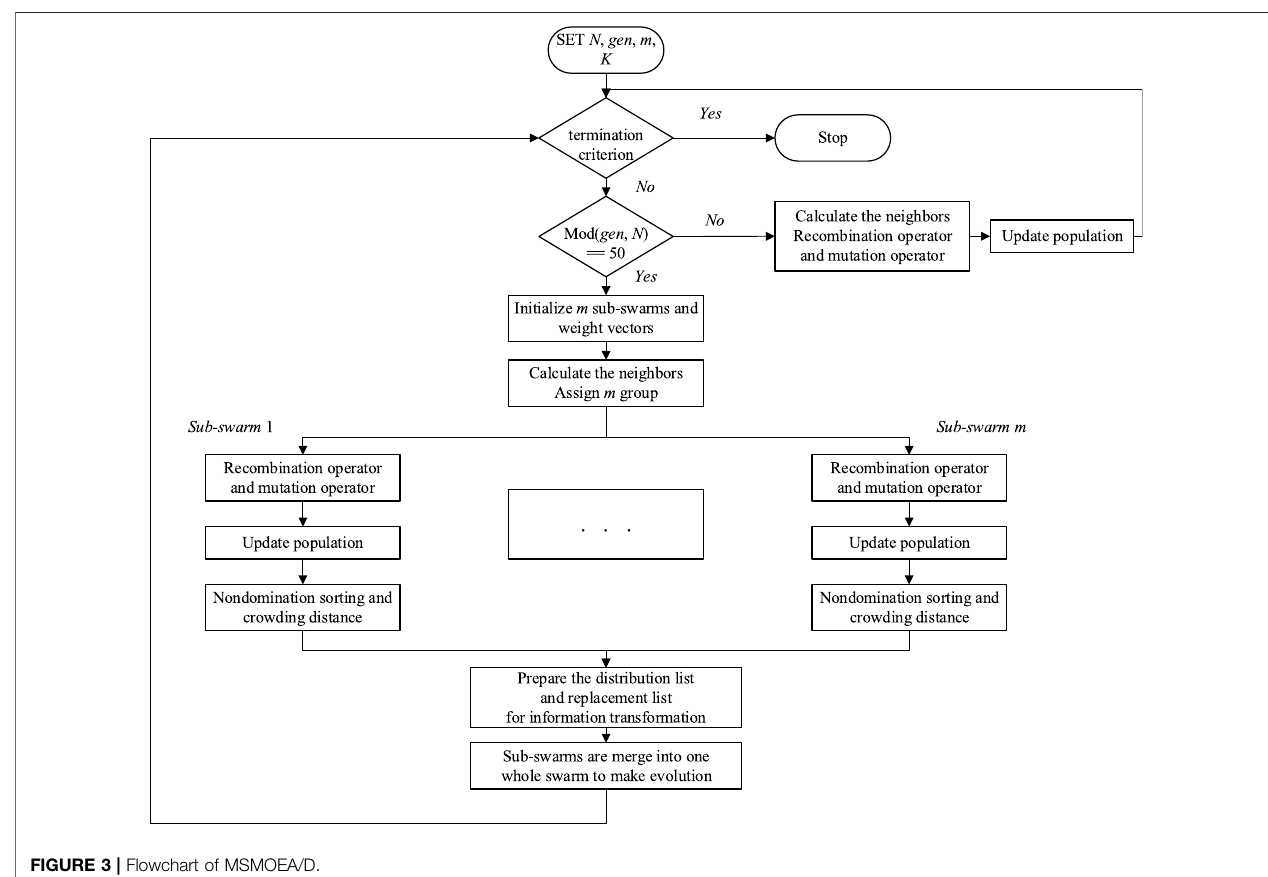
FIGURE 3 | Flowchart of